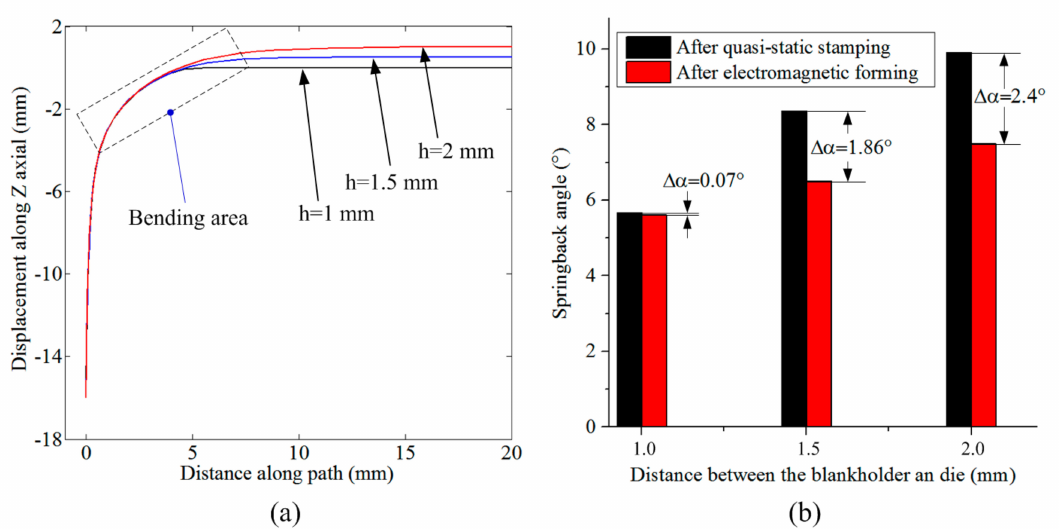
Figure 11. Deformation and springback reduction based on ( a ) sheet profiles after quasi-static stamping and ( b ) springback angle after coil discharge versus quasi-static stamping.